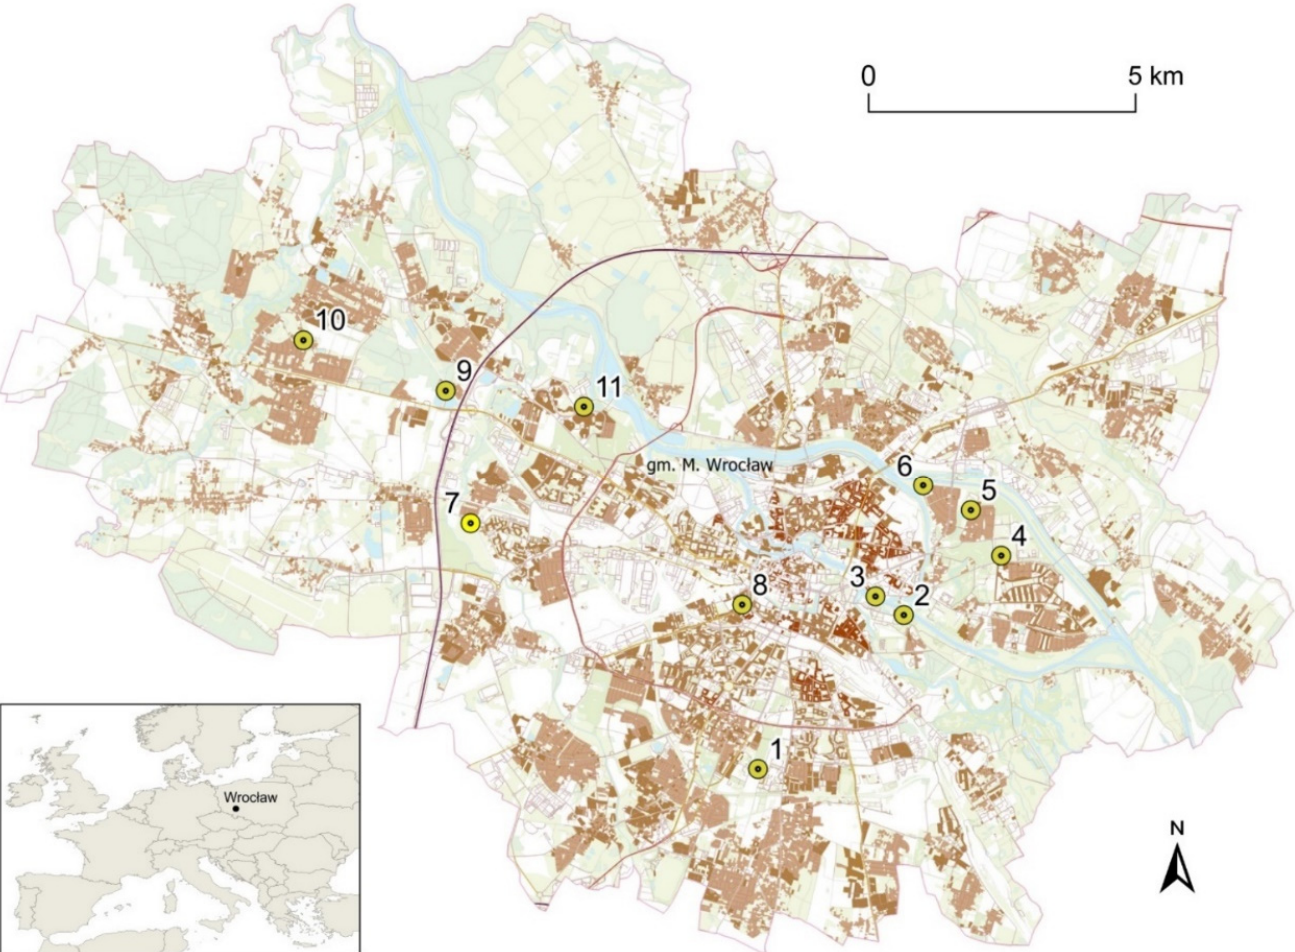
Figure 3. Study area. Locations of beach volleyball courts examined for sand characteristics are marked: 1—Skowroni Park (Weigla St.); 2—KS AZS Wratislavia (Na Grobli St.); 3—Wroc ł aw University of Science and Technology, PWR (Wybrze ż e Stanis ł awa Wyspia ń skiego); 4—Wroc ł aw University of Health and Sport Sciences, AWF (Adama Mickiewicza St.); 5—‘Morskie Oko’ swimming facility (Fryderyka Chopina St.); 6—GEM Sports Complex (Mianowskiego St.); 7—Millennium Park (Sukielicka St.); 8—LGW Arena court (Prosta St.); 9—‘Glinianki’ swimming facility (Kosmonautów St.); 10—Primary School No. 95 (Stanis ł awa Iwaszkiewicza St.); 11—K69 hall (Kozanowska St.). Map based on BDOT10K database made available by the Central Office of Geodesy and Cartography, Poland (geoportal.gov.pl, public domain).